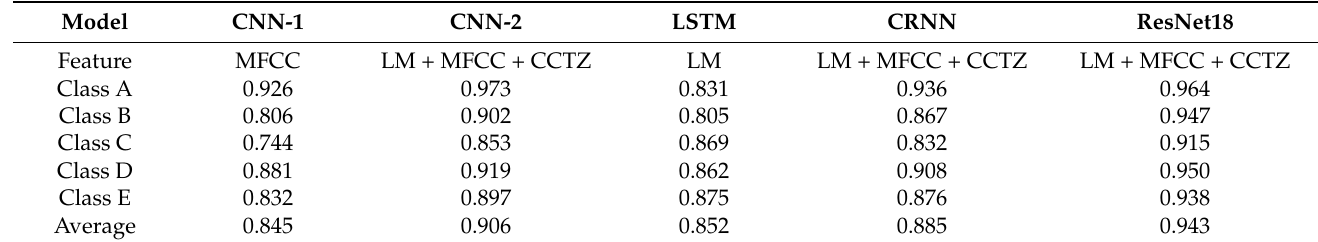
Table 4. The comparison of different